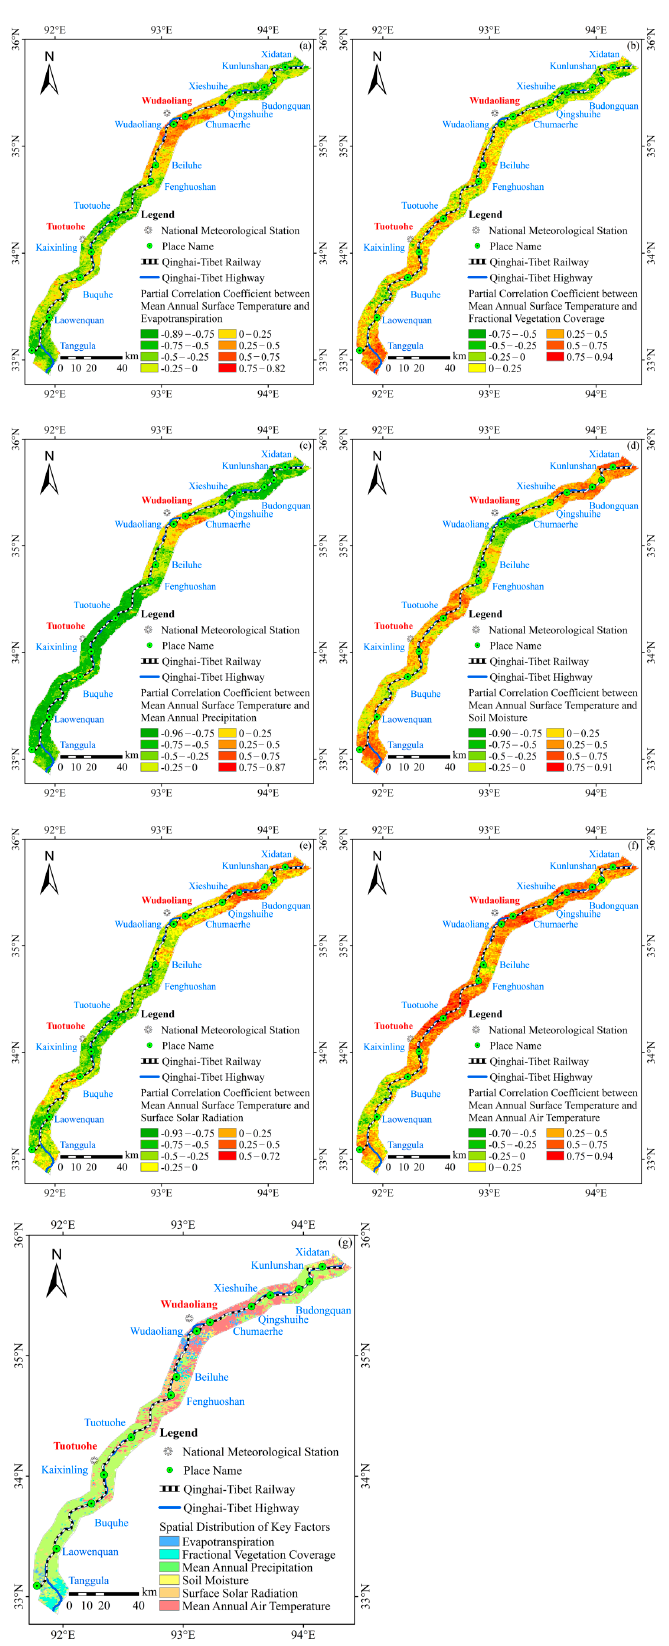
Figure 16. Spatial distribution of the partial correlation coefficient between MAST and driving factors, and key factors affecting MAST: ( a ) ET; ( b ) FVC; ( c ) MAP; ( d ) SM; ( e ) SR; ( f ) MAAT; ( g ) key factors.